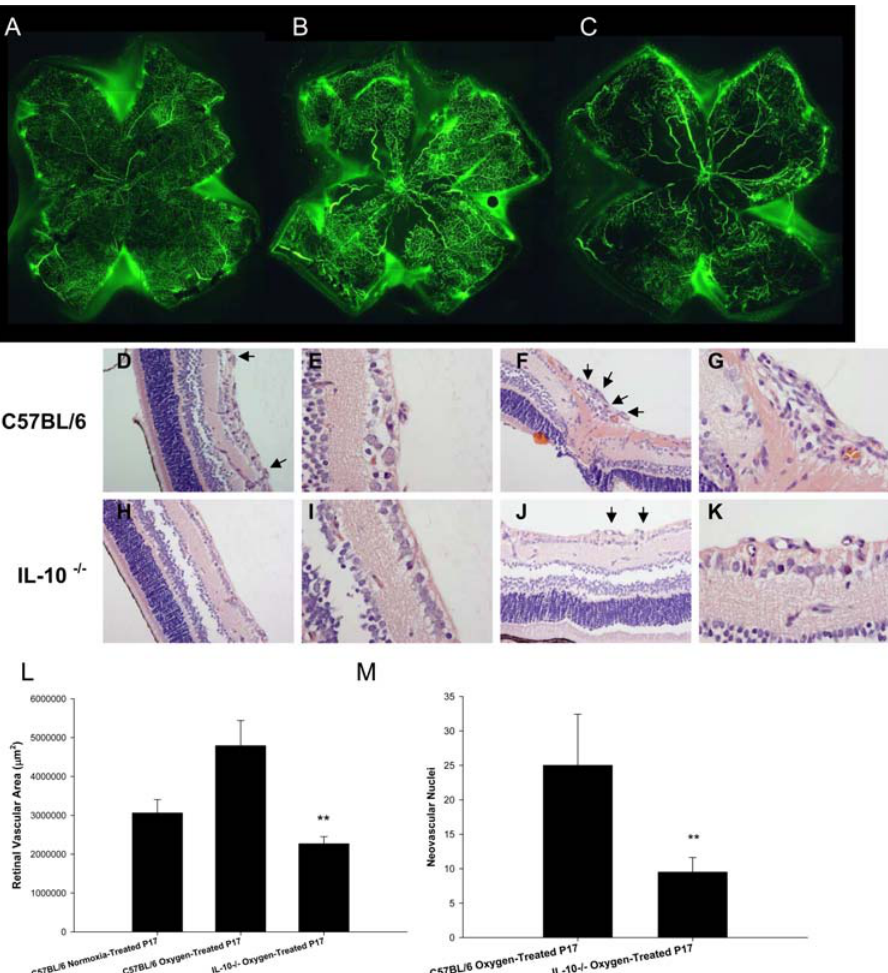
Figure 1. IL-10 2 / 2 mice demonstrate significantly reduced retinal neovascularization in response to ischemia. C57BL/6 and IL-10 2 / 2 were exposed to 75% 6 2% O 2 from day P7 to P12. Mice were returned to normoxic conditions for 5 days, and on P17 animals were perfused with FITC-dextran, eyes harvested, and retina flatmounts made. Fluorescent microscopy of perfused retinas of (A) normoxic-treated wild-type mice (n=5), (B) oxygen-treated wild-type mice (n=5), and (C) oxygen-treated IL-10 2 / 2 mice (n=4) reveal decreased angiogenesis and increased areas of non- perfusion in IL-10 2 / 2 mice. This experiment was repeated 2 additional times with similar results (D–G) H&E staining of ocular tissue sections from C57BL/6 oxygen-treated mice exhibit extensive preretinal neovascular loops (arrows), whereas (H–K) ocular tissue sections from IL-10 2 / 2 oxygen- treated mice demonstrate a significant reduction in preretinal neovascular loops. Images were acquired at both 40 6 (D,F,H,J) and 100 6 (E,G,I,K). (L) The total area of retinal vascularization was quantified using Metamorph TM software as described in Materials and Methods, and plotted as a bar graph. IL-10 2 / 2 mice exposed to oxygen had significantly reduced (**P=0.0006) retinal vascularization compared to wild-type mice exposed to oxygen. (M) A bar graph represents the mean 6 SD number of neovascular loops of 10 separate sections, with IL-10 2 / 2 mice demonstrating reduced neovascular loops (**P=0.0071) compared to wild-type mice following OIR.